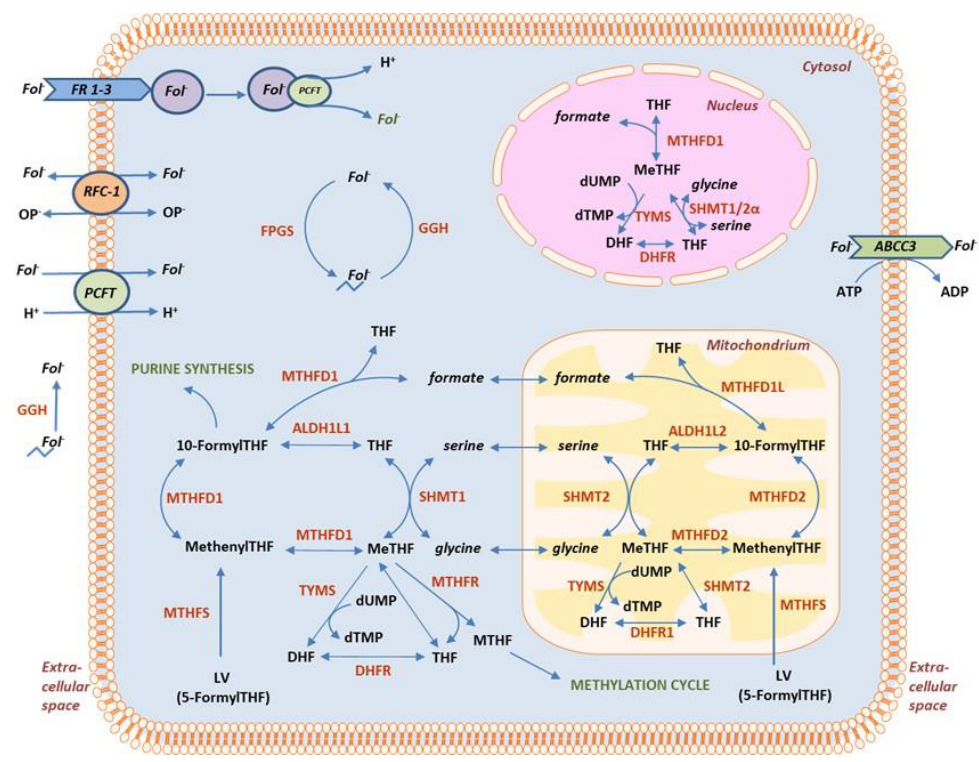
Figure 1. Simplified overview showing compartmentalization of folate metabolism in eukaryotic cells. Monoglutamated folates ( Fol − ), including leucovorin (LV), enter cells through RFC-1, PCFT, or FRs. Inside cells, polyglutamation of folates occur through the action of FPGS, whereas GGH yields monoglutamated folates. These may be exported out of cells by ABCC3. In the cytosol, LV may be enzymatically converted to MeTHF by two different routes: either by MTHFS and MTHFD1, or by MTHFS, MTHFD1, ALDH1L1, and SHMT1. Similar reactions occur in the mitochondria, where LV can be converted to MeTHF by MTHFS and MTHFD2, or by MTHFS, MTHFD2, ALDH1L2, and